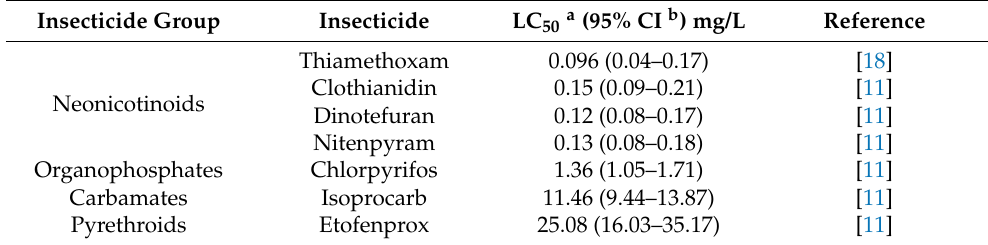
Table 2. The LC 50 values of the reference susceptible strains of S. furcifera .